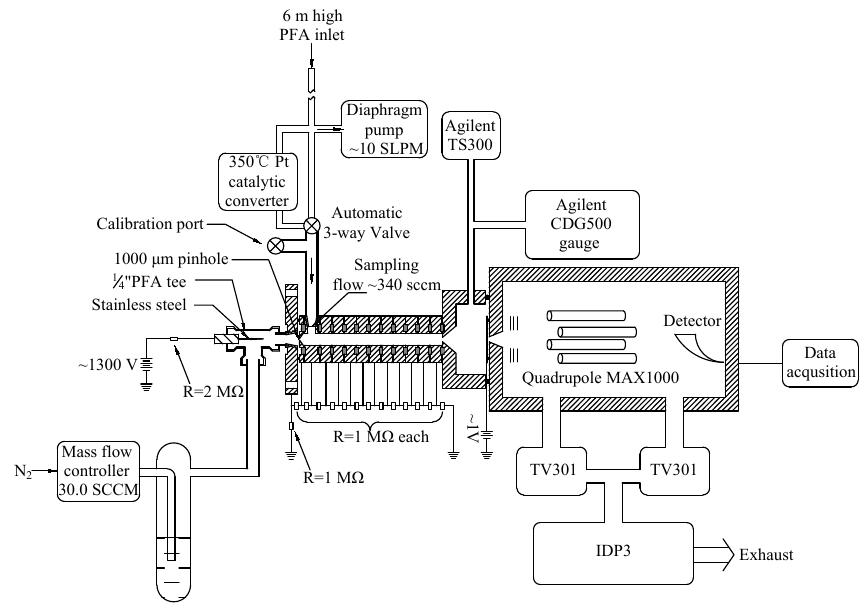
Figure 1. Schematic diagram of the proton transfer reaction ion-drift chemical ionization mass spectrometer